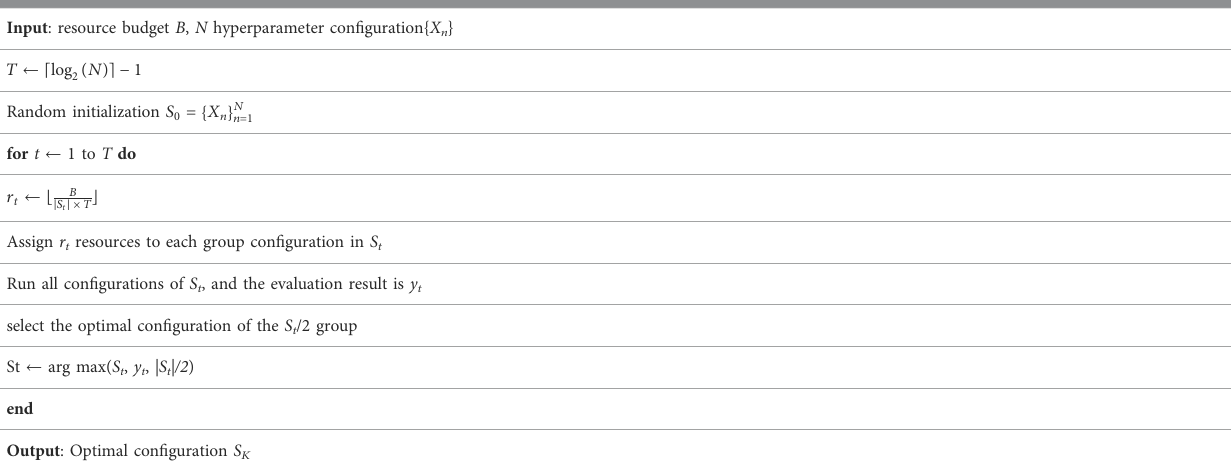
TABLE 1 Successive halving algorithm. Algorithm: a dynamic resource allocation method of halving successively